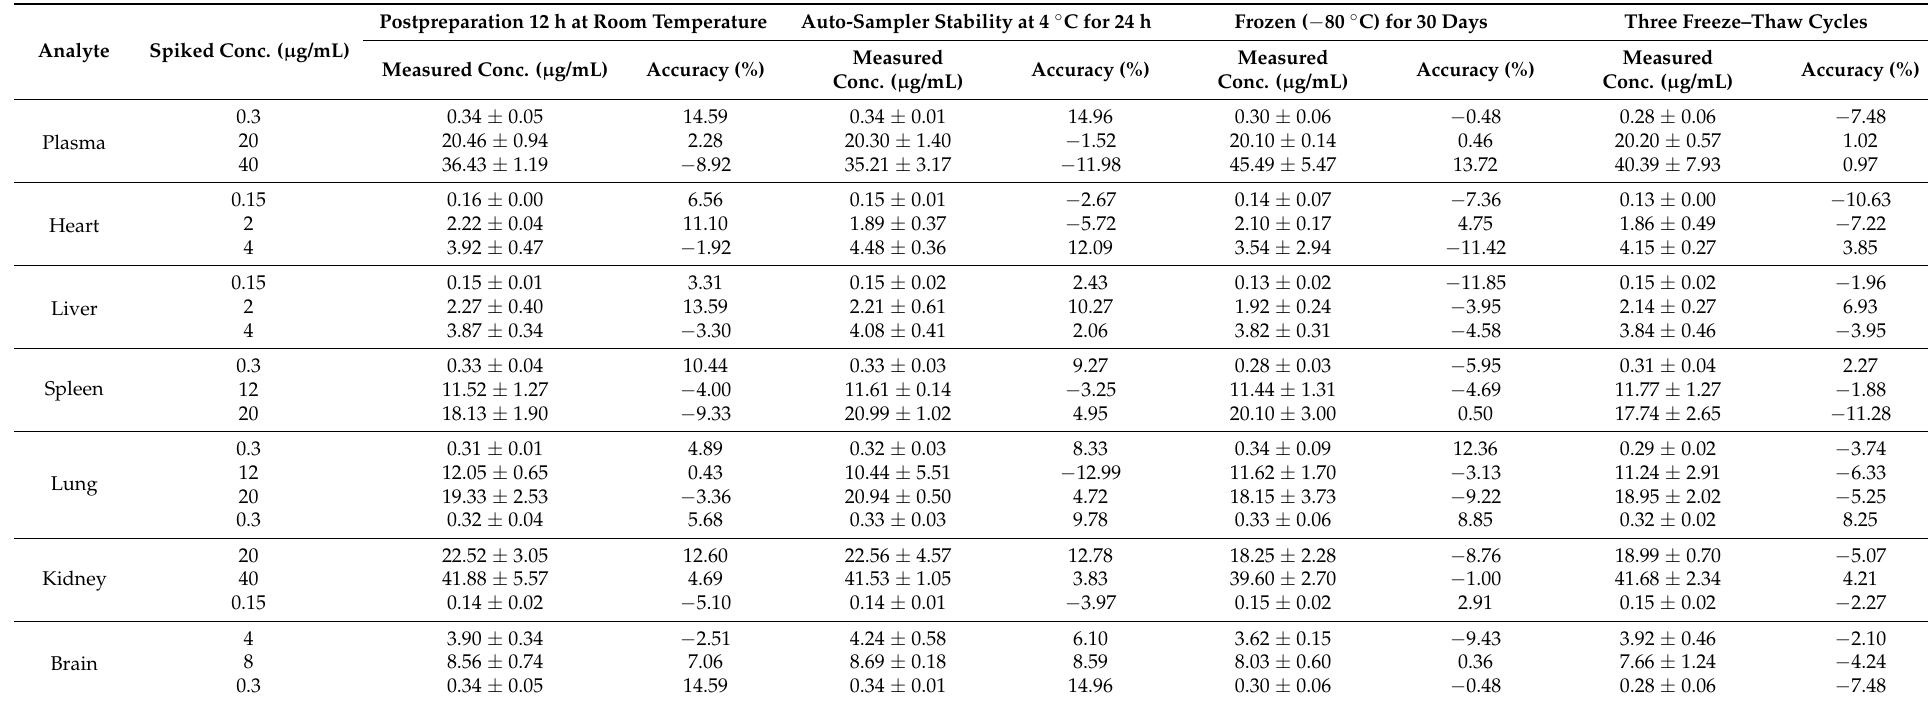
Table 5. Stability of Acipimox in the plasma and tissue of rats ( n = 6